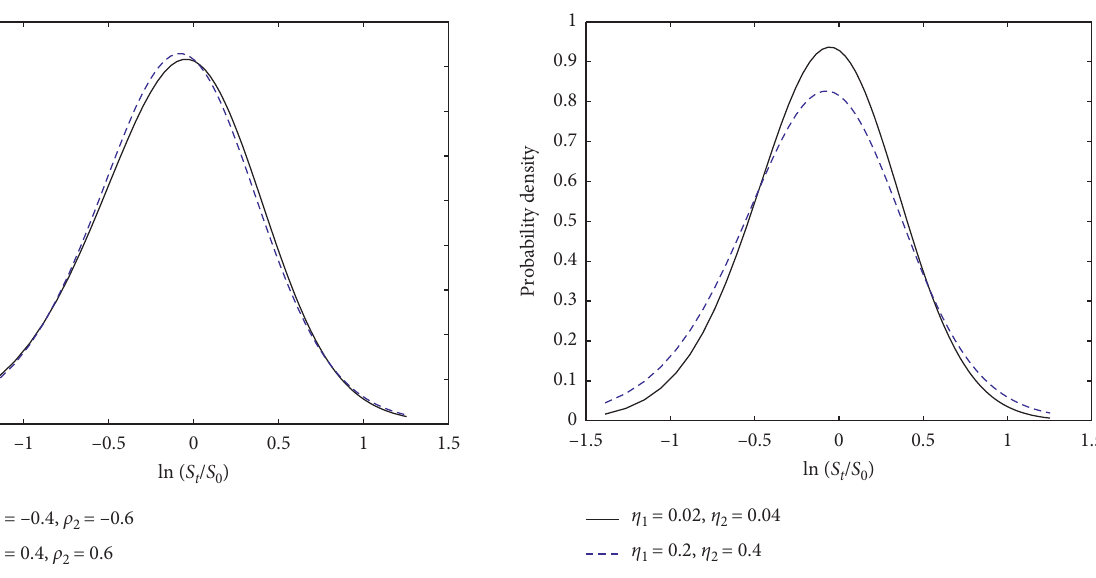
Figure 5: Probability density function with different correlations and ρ . ρ 1 2